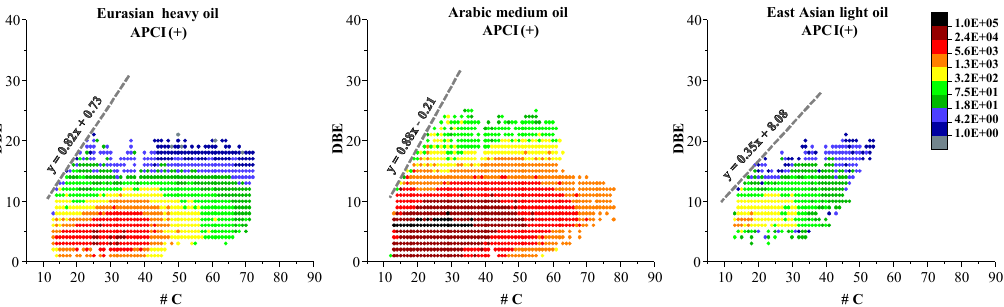
Figure 6. Kendrick plots of the S[H] class for APCI( + ) measurements of saturates from Eurasian heavy oil ( left ) Arabic medium oil ( middle ) and E. Asian light oil ( right ). Color-coding represents the intensity of the corresponding monoisotopic signal.